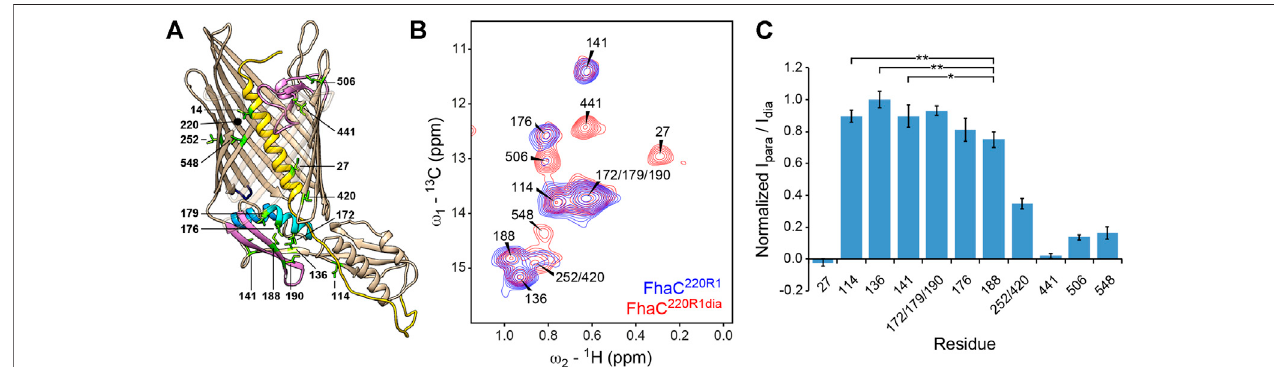
FIGURE 3 | NMR analysis of Ile δ 1 -methyl labeled FhaC in lipid bilayers. (A) Structure of FhaC with Ile residues labeled and drawn as green sticks. Color code of structural elements isas in Figure 2 . β -strands12to 15 are drawn transparently for visibility. The position of residue 220 used for PREexperiments is also indicated. (B) Superposition of the methyl regions of solid-state dipolar hCH 13 C- 1 H correlation spectra of u-( 2 H, 15 N), Ile- δ 1 ( 13 CH 3 )-labeled FhaC samples in E. coli polar lipid liposomes, with a paramagnetic MTSL tag (FhaC 220R1 , blue) or with a diamagnetic MTSL analog (FhaC 220R1dia , red) attached to the introduced Cys 220 residue. Spectra were recorded at 800 MHz 1 H Larmor frequency and 50 kHz MAS. (C) Ratios I para / I dia of Ile- δ 1 methyl peak intensities in the hCH correlation spectra of FhaC 220R1 and FhaC 220R1dia shown in (B) , normalized to the maximum ratio observed in Ile 136 . Error bars are calculated based on spectral noise levels. * and ** indicate signi fi cant ( p < 0.05 and p < 0.01, respectively) attenuation of the Ile 188 signal relative to the signals of the reference residues Ile 114 , Ile 136 , and Ile 141 . See also Supplementary Figure S5